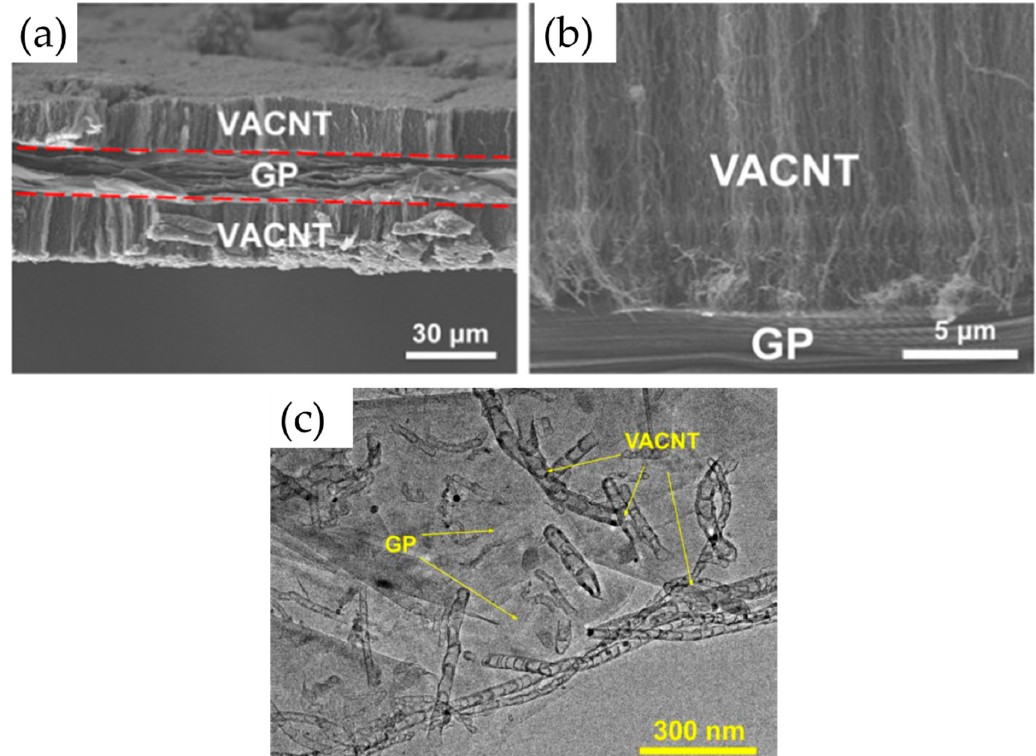
Figure 22. SEM images of ( a ) single layer of GP with VACNT and ( b ) magnification of the compo- site interphase. ( c ) TEM image GP sheets with grafted bamboo-like CNT following an ultrasonic sample preparation treatment. Adapted with permission from He, ACS Applied Nano Materials; Ref. [49] copyright 2022, American Chemical Society.